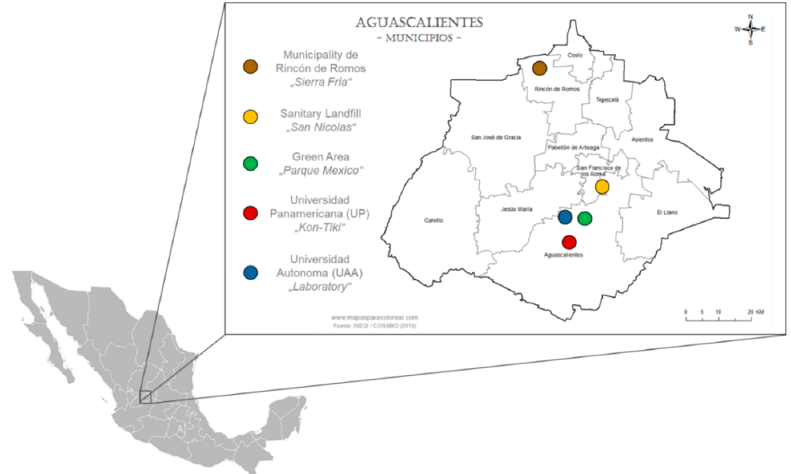
Figure 1. Location of three feedstock sampling sites, pyrolysis, and the laboratory site in the state of Aguascalientes, Mexico. Brown dot: Municipality of Rincón de Romos—“Sierra Fria”; yellow dot: Sanitary Landfill—“San Nicolas”; green dot: Green Area—“Parque Mexico”; Red dot: Universidad Panamericana—“Kon-Tiki flame curtain kiln”; blue dot: Universidad Autónoma de Aguascalientes—“Laboratory”.